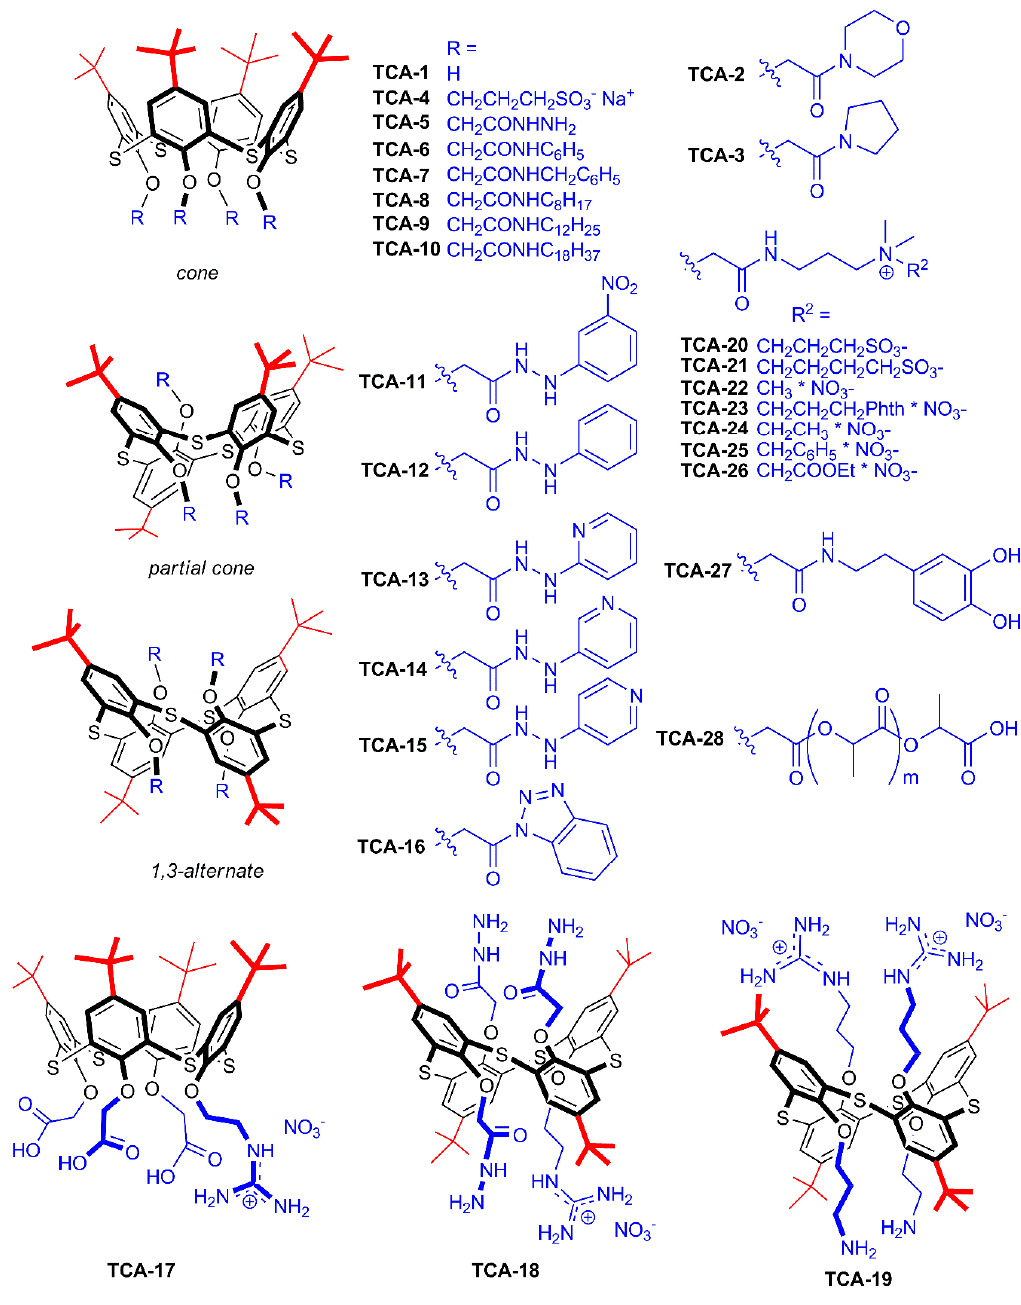
Figure 5. Structures of